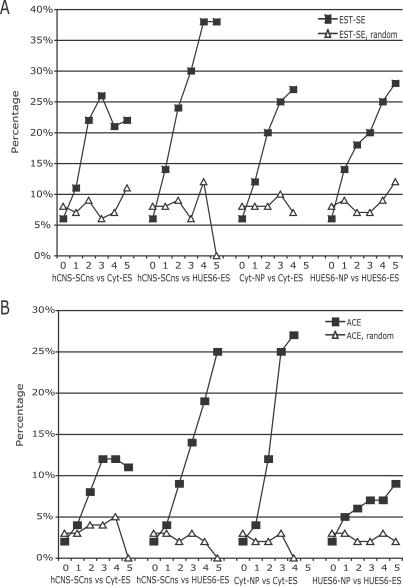
Comparison of REAP Predictions for hCNS-SCns versus Cyt-hES, hCNS-SCns versus HUES6-ES, Cyt-NP versus Cyt-ES, and HUES6-NPs versus HUES6-ES with Alternative Exons Identified by an EST-Based Method and ACEScan(A) Black-filled squares represented the fraction of exons containing probesets with N significant points that had EST evidence for exon inclusion or exclusion (N = 0, 1, 2, 3, 4 and 5). White-filled triangles represented similarly computed fractions with permuted probeset to exon mappings.(B) Black-filled squares represented the fraction of exons containing probesets with N significant points that had ACEScan positive scores, indicative of evolutionarily conserved alternative exons. White-filled triangles represented similarly computed fractions with permuted probeset to exon mappings.